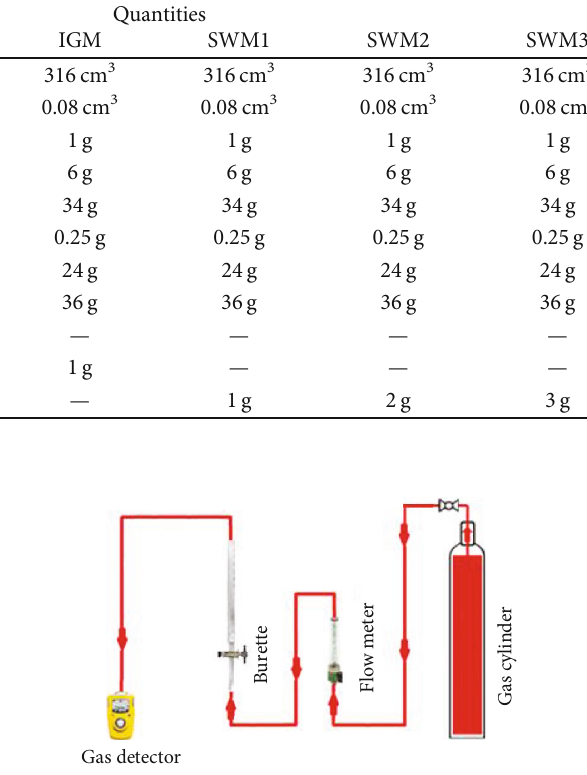
Figure 1: Setup for the H